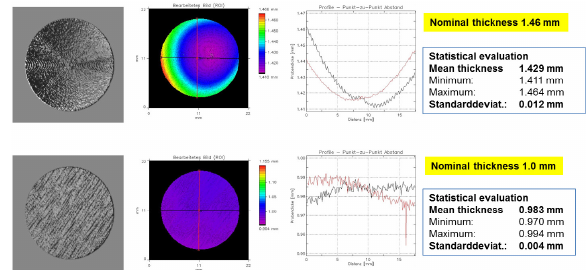
Fig. 6. Thickness evaluation of two beryllium samples with a nominal thickness of 1.46 mm (top) and 1.0 mm (bottom). From left to right: Thickness values as photorealistic view, 2D colour-coded, as graph along the profile lines, and the statistical evaluation (with the standard deviation from the mean).